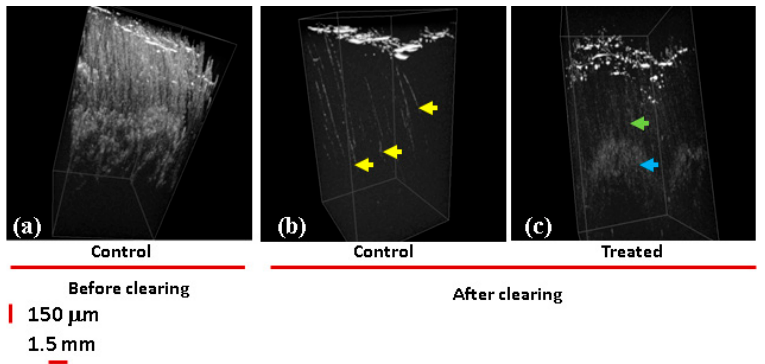
Figure 5. 3D OCT images of white skin samples. ( a ) No clearing, control samples incubated with PBS. Both control and samples treated with 100 ND show high levels of scattering on the skin layers. Clearing: ( b ) control; a 3D OCT image reveals scattering areas corresponding to the hair follicles (yellow arrow heads). ( c ) Sample incubated with 100 ND; areas of high scattering are observed distributed in different layers of the epidermis: along the hair shaft (dense, green arrow) and in the hair follicle (cloudy, blue arrow).